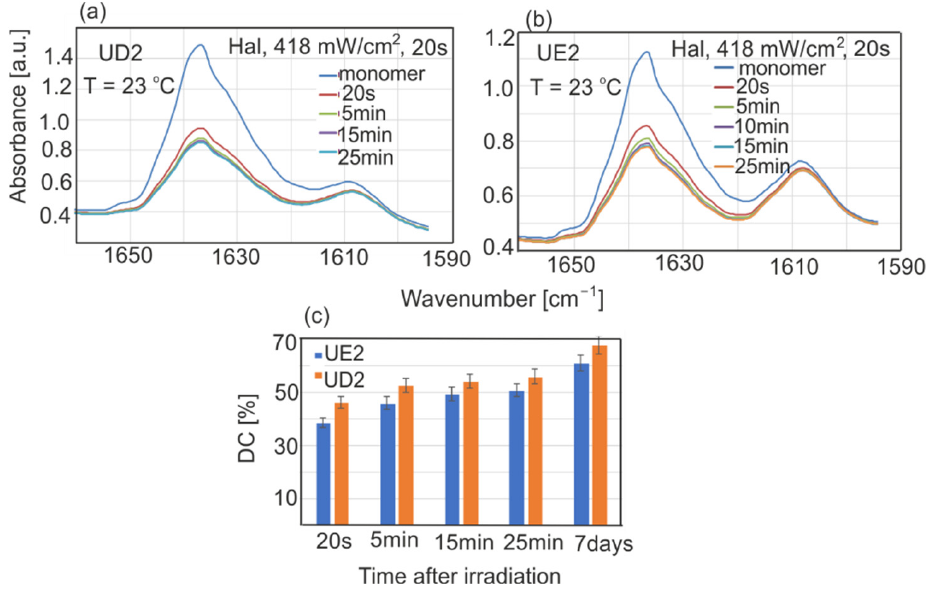
Figure 7. Changes in resin absorption during polymerization after radiation with the halogen (Hal) source at 23 °C: ( a ) UD2, ( b ) UE2, ( c ) calculated DC values.